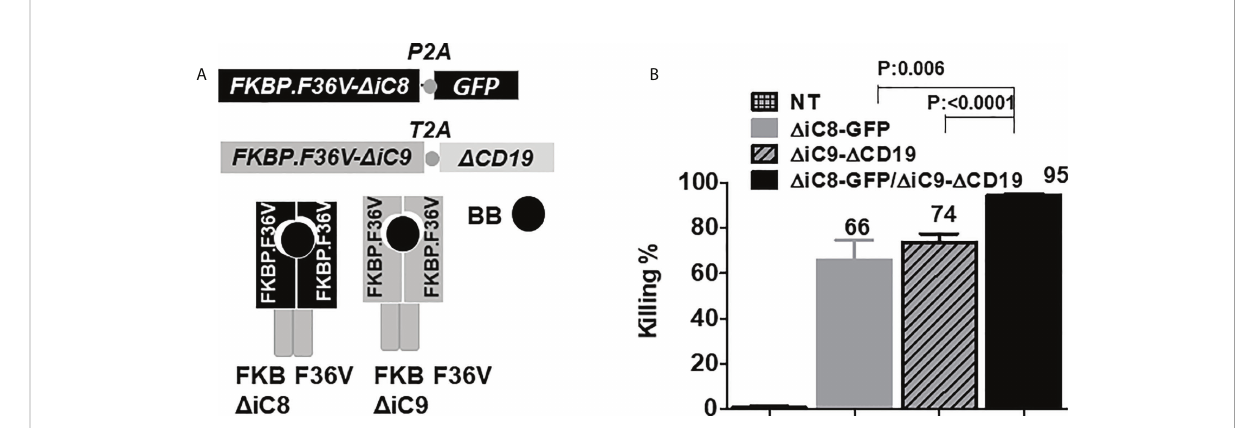
FIGURE 1 (A) F36V D iC8 and F36V D iC9 retroviral constructs and proteins diagram, activatable by a BB homodimerizer. (B) Inducible elimination of D iC8- GFP, D iC9- D CD19, and D iC8+ D iC9 co-expressing Jurkat cells (N=5-7 experiments) after overnight exposure to the BB homodimerizer at a concentration of 100